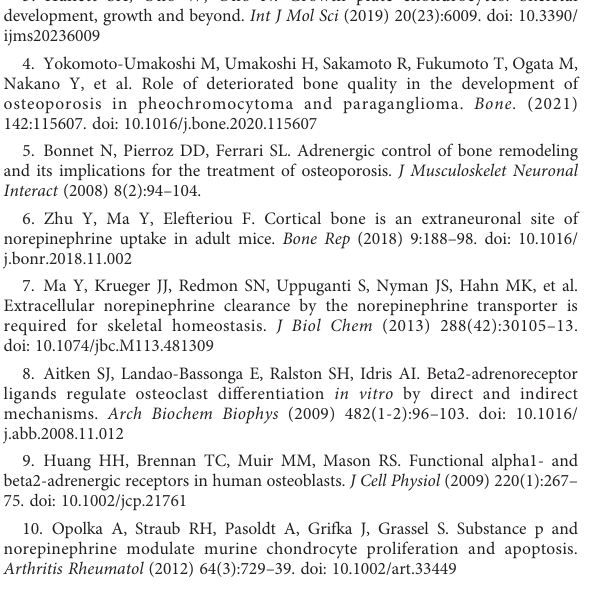
SUPPLEMENTARY FIGURE 1 Genotyping and veri fi cation of the TH knockout in TH CD11b-Cre mice. Gel